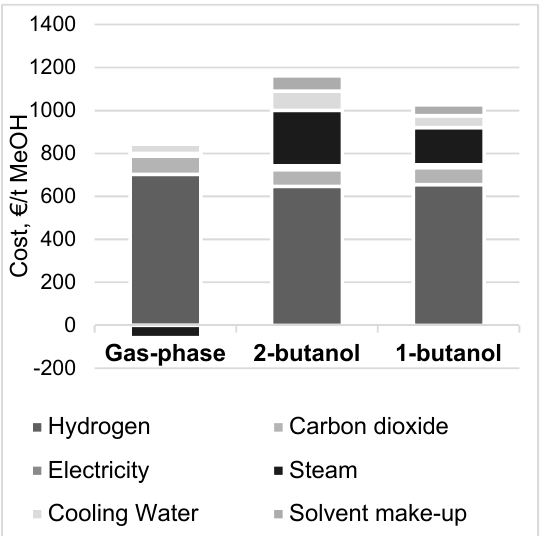
Figure 6. Distribution of the variable production costs in three CO 2 hydrogenation to methanol processes: the gas-phase process, the liquid-phase process with 2-butanol solvent, and the liquid-phase process with 1-butanol solvent.